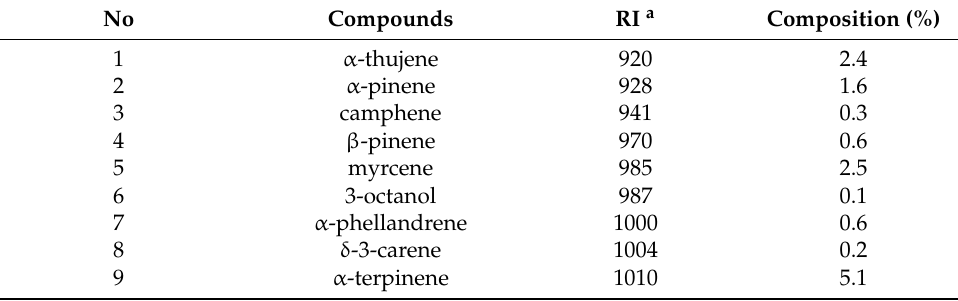
Table 2. Chemical composition (% v / v ) of S. thymbra essential